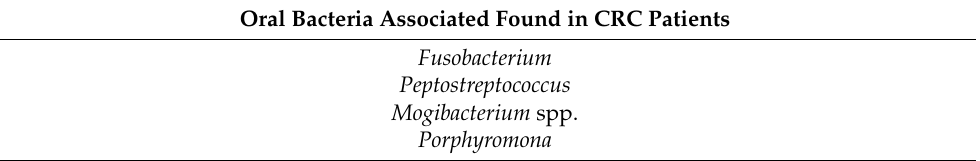
Table 2. The oral bacteria found within tissue samples of CRC patients include Fusobacterium , Peptostreptococcus , Mogibacterium spp. and Porphyromona [32]. Oral Bacteria Associated Found in CRC Patients